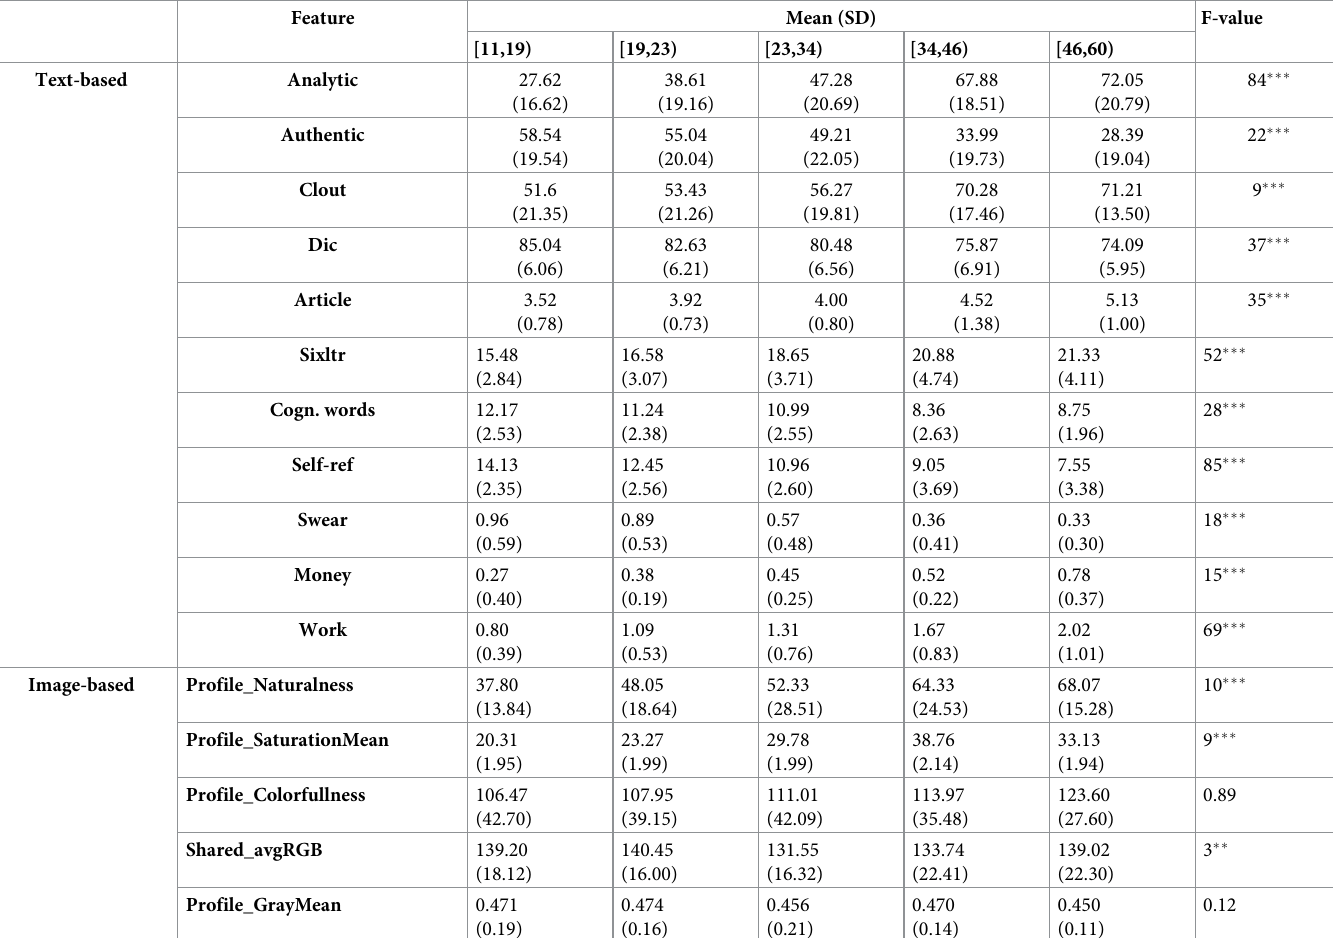
Table 5. Statistical significance test of linguistic patterns/visual attributes for different age groups with one-way ANOVA, ��� alpha = 0.001, �� alpha =